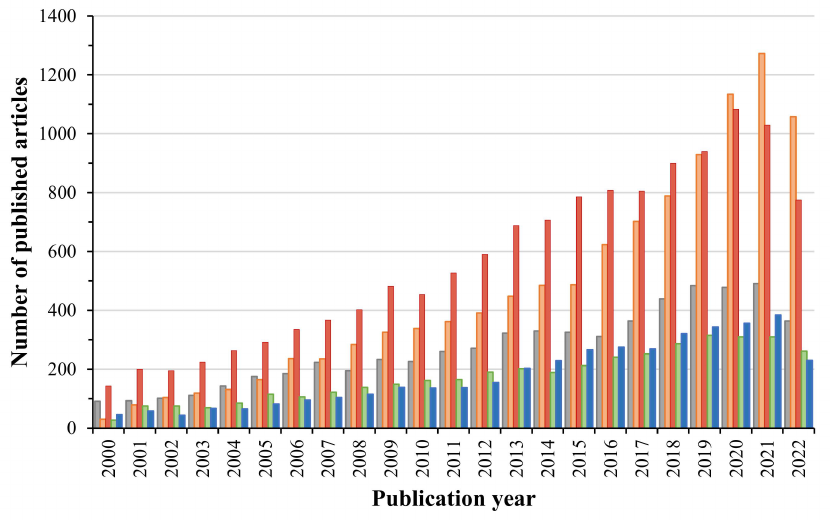
Figure 1. Publications reporting the occurrence of ECs in different water systems from 2000–Present ( (cid:4) —groundwater; (cid:4) —drinking water or tap water; (cid:4) —wastewater; (cid:4) —surface water; (cid:4)